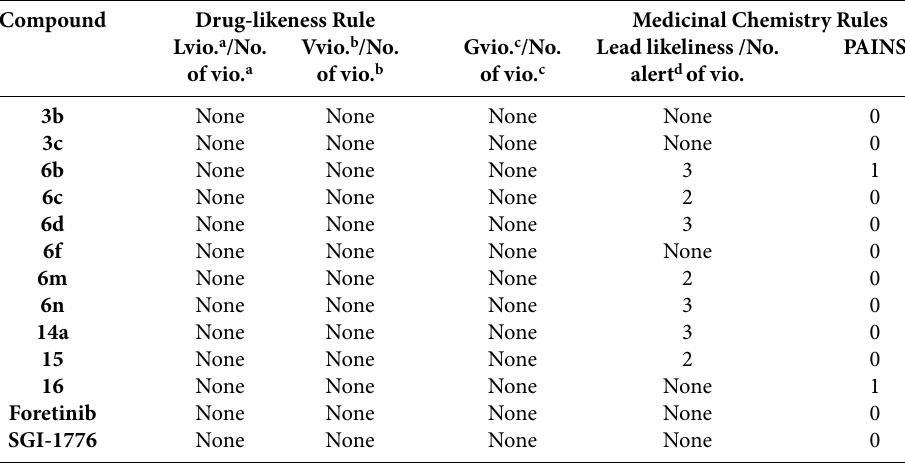
a Lvio. = Lipinski’s rule. b Vvio. = Veber Rules. c Gvio. = Ghose filter. d PAINS = Pan Assay Interference Compounds